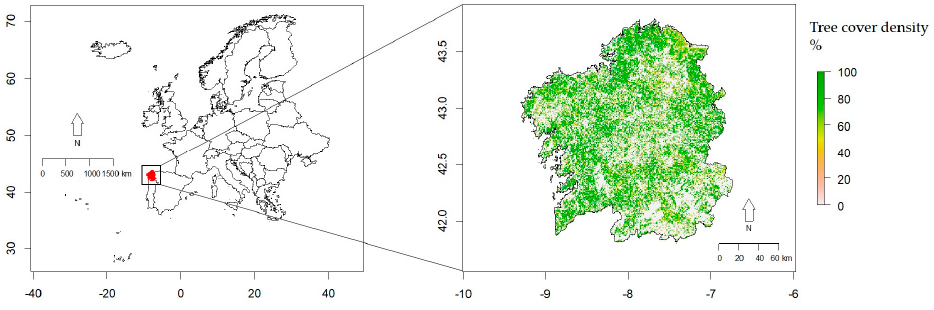
Figure 1. Location and tree cover density of Galicia, Spain.